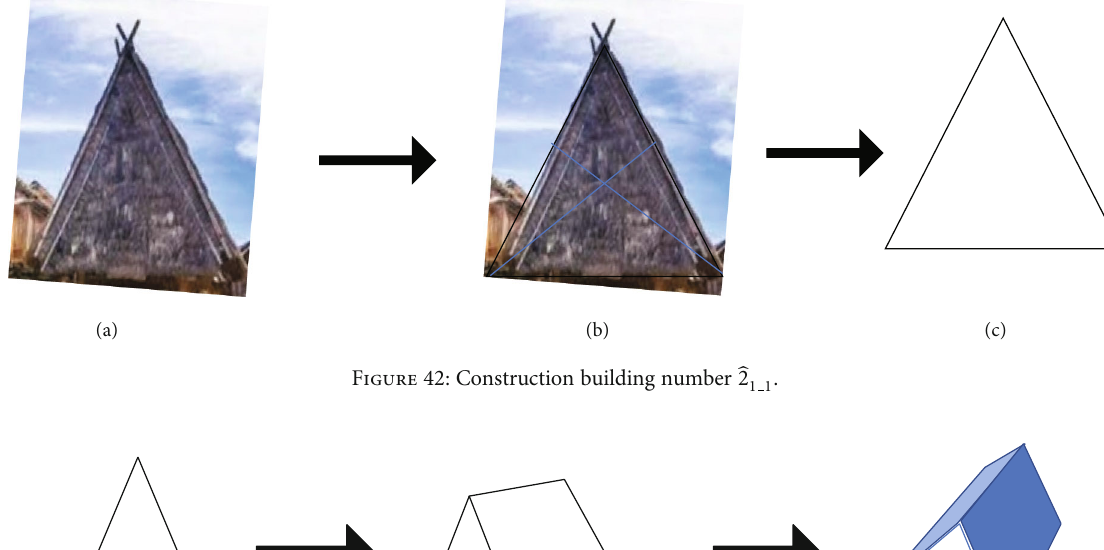
Figure 43: Construction building number ̂ 2